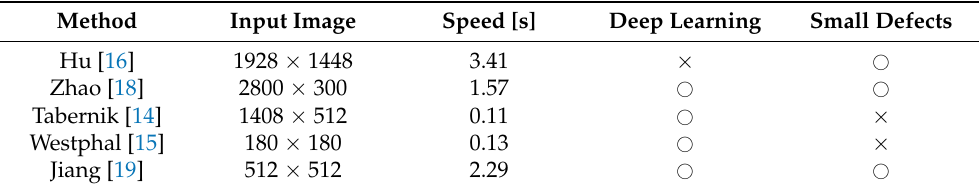
Table 1. Performance comparison of existing defect detection models.